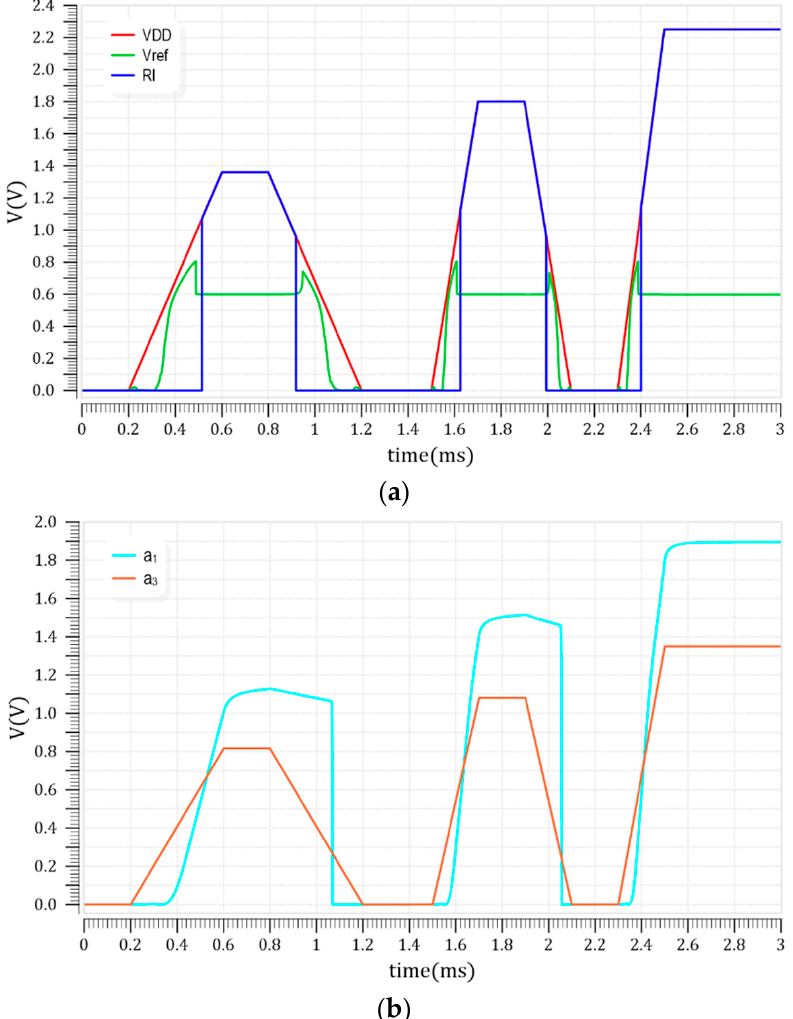
Figure 4. The BGR#1 (22 nm, 1.8 V) Ready-Indication for different power-up and power-down conditions at a typical temperature (27 ◦ C). ( a ) Important input-output voltages and ( b ) internal critical voltages used for